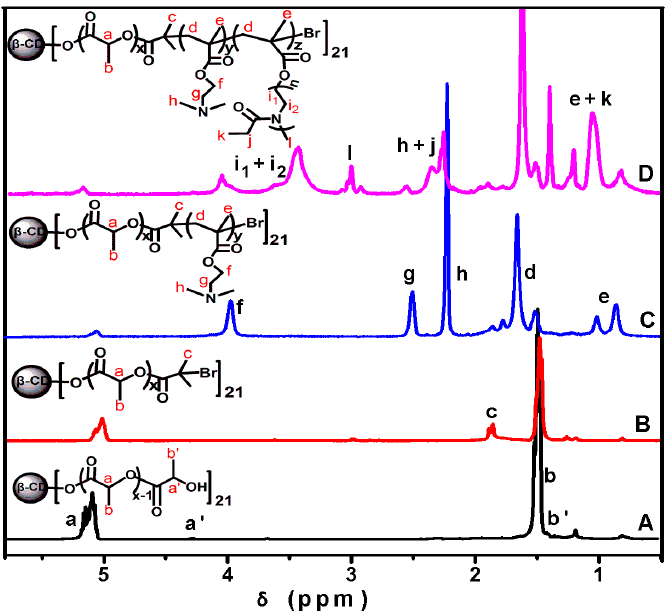
Figure 2. 1 HNMRspectraof β -CD-(PLA-OH) 21 ( A ); β -CD-(PLA-Br) 21 ( B ); β -CD-(PLA- b -PDMAEMA) 21 ( C ); Figure Figure 2. and β -CD-(PLA- b -PDMAEMA- b -PEtOxMA) 21 ( D ) in CDCl 3